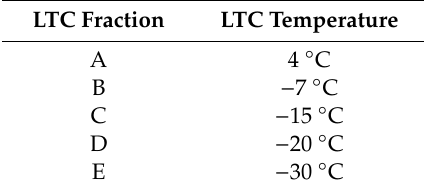
Table 1. PUFAs fractionation by